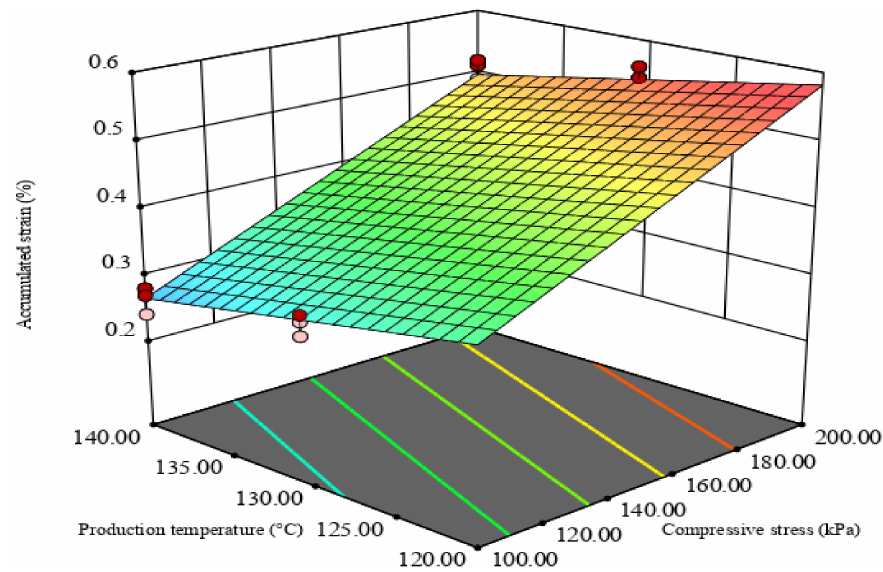
Figure 15. Plot of the interaction between the factors and the response of the linear